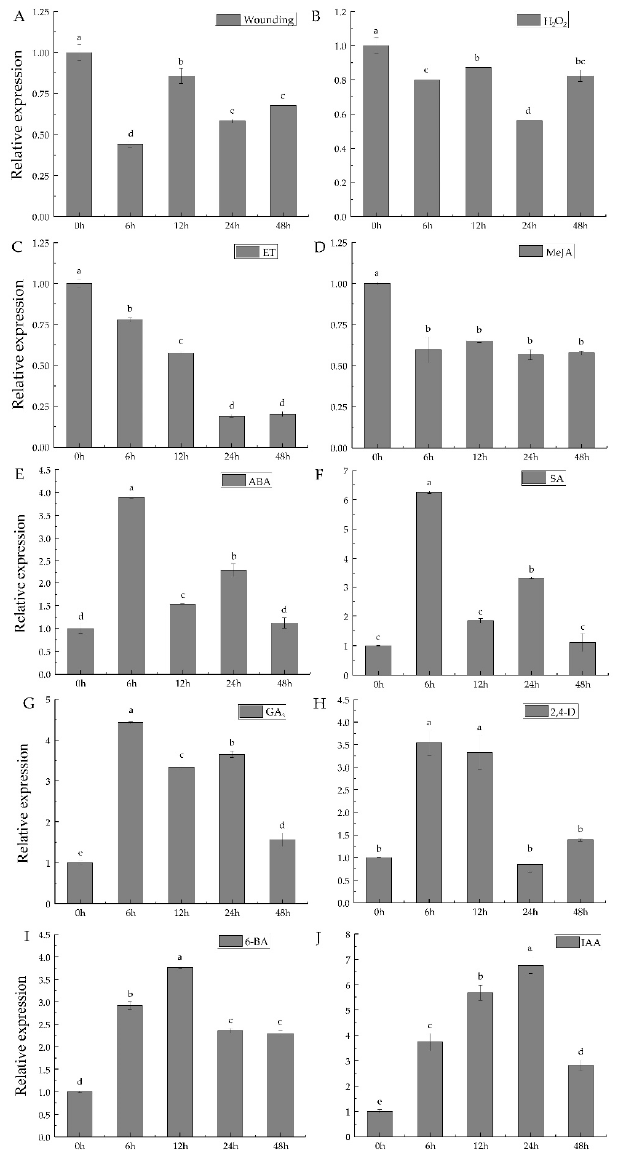
Figure 4. Expression profiles of the HbSRGRX1 gene under different treatments. Expression profiles of HbSRGRX1 in latex at 6, 12, 24, and 48h after wounding ( A ), hydrogen peroxide (H 2 O 2 ) ( B ), ethephon (ET) ( C ), methyl jasmonate (MeJA) ( D ), abscisic acid (ABA) ( E ), salicylic acid (SA) ( F ), gibberellic acid (GA 3 ) ( G ), 2,4-dichlorophenoxyacetic acid (2,4-D) ( H ), 6-Benzylaminopurine (6-BA) ( I ), and indole-3-acetic acid (IAA) ( J ) treatments. Untreated trees were used as the control (0 h). Relative expression was normalized using 18S rRNA gene. Values represent mean ± SD of three independent replicates. Different letters indicate significant difference ( p <